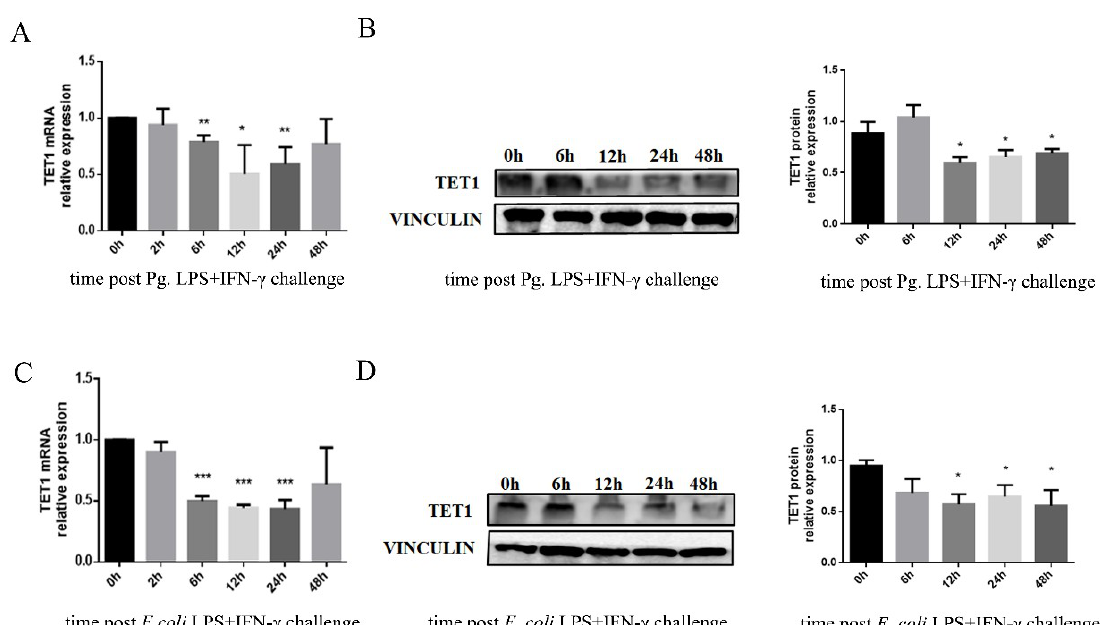
Figure 3. TET1 expression in M1 macrophages during LPS/IFN-γ stimulation. ( A,C ) The mRNA expression of TET1 was measured by qRT-PCR in cells after stimulation with Pg. LPS/IFN-γ ( A ) or E. coli LPS/IFN-γ ( C ) for 2, 6, 12, 24, and 48 h. GAPDH was used as an internal control. ( B,D ) The protein expression of TET1 was measured by Western blot analysis after stimulation with Pg. LPS/IFN-γ ( B ) or E. coli LPS/IFN-γ ( D ) for 6, 12, 24, and 48 h. VINCULIN was used as an internal control. All of the results represent the mean ± standard deviation of three independent experiments ( n = 3). * p < 0.05, ** p < 0.01, and *** p < 0.0001 represent significant differences compared with the control.